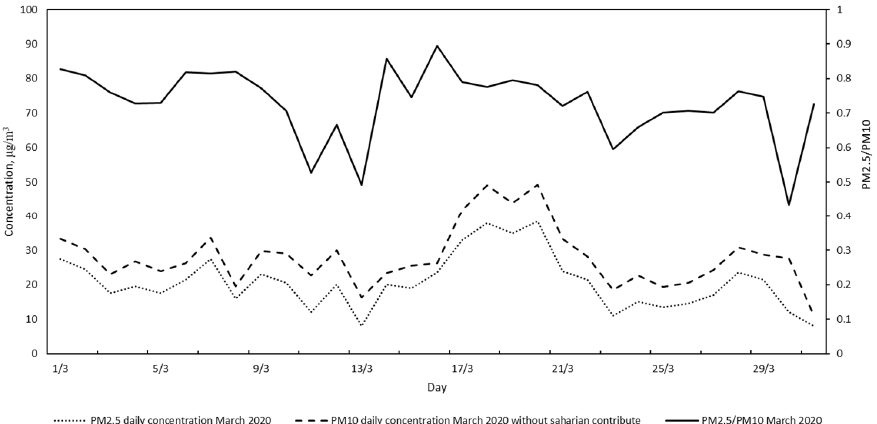
Figure 6. PM10 daily average without saharan contribute estimated (dashed black line), PM2.5 daily average (dotted black line), ratio between PM2.5 and PM10 (solid black line) measured in Milan by